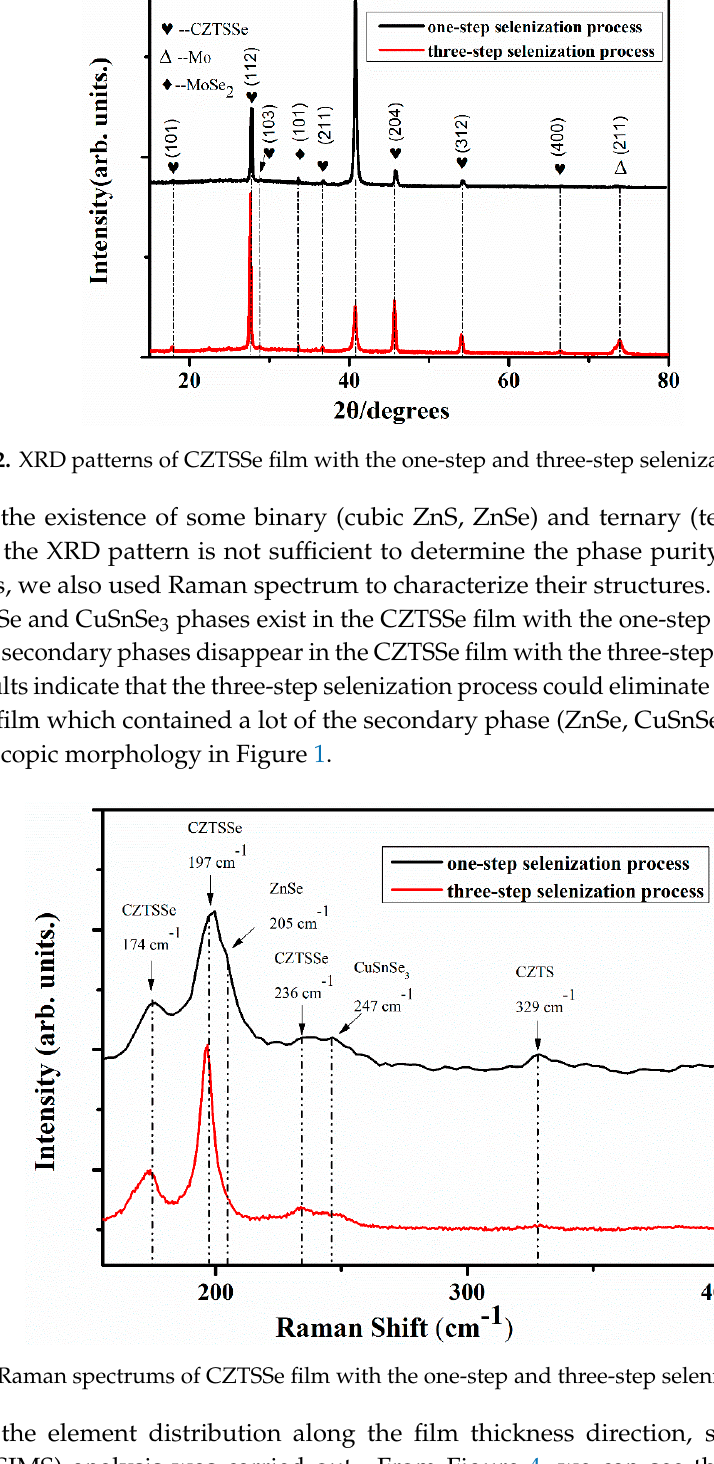
4 of 9 Figure 1. Surface and cross-sectional SEM images of ( a,d ) CZTS precursor film, ( b,e ) CZTSSe film with the one-step selenization process, ( c,f ) CZTSSe film with the three-step selenization process. Figure 1 shows the FE-SEM images of the CZTS precursor and CZTSSe thin films. Figure 1(a–f) correspond the top surface and cross-sectional images of the CZTS precursor and the CZTSSe films with the one-step and three-step selenization process, respectively. As shown in Figure 1(a), there are numerous holes and cracks in the surface of the CZTS precursor film, and these defects provide the channel for the diffusion of Se atoms. By comparing the images of CZTSSe films with the one-step and three-step selenization process, we can observe that the crystallinity of CZTSSe films with the three-step selenization process is enhanced with a larger grain size. Further, both of the two samples show a bi-layer structure. As explained before, the formation of the bi-layer structure is due to the Se vapour reacting with the upper CZTS particles and translating to a CZTSSe crystallized grain layer.